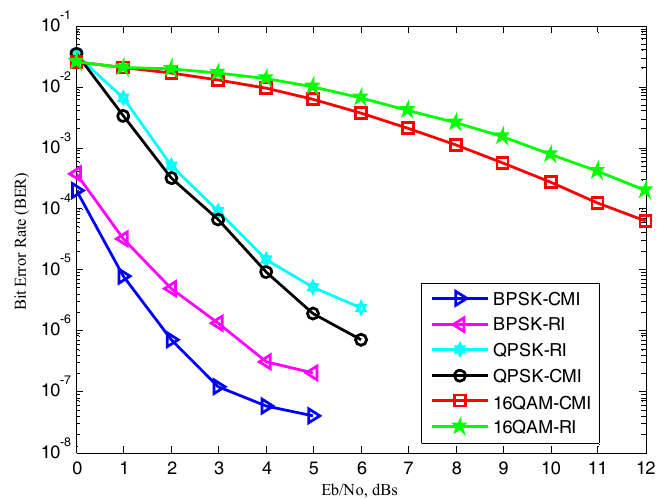
Figure 8 . BER performance of turbo coded OFDM with MIMO (2 × 2) antennas over Rayleigh fast fading channel, L = 1024 and four decoding iterations.